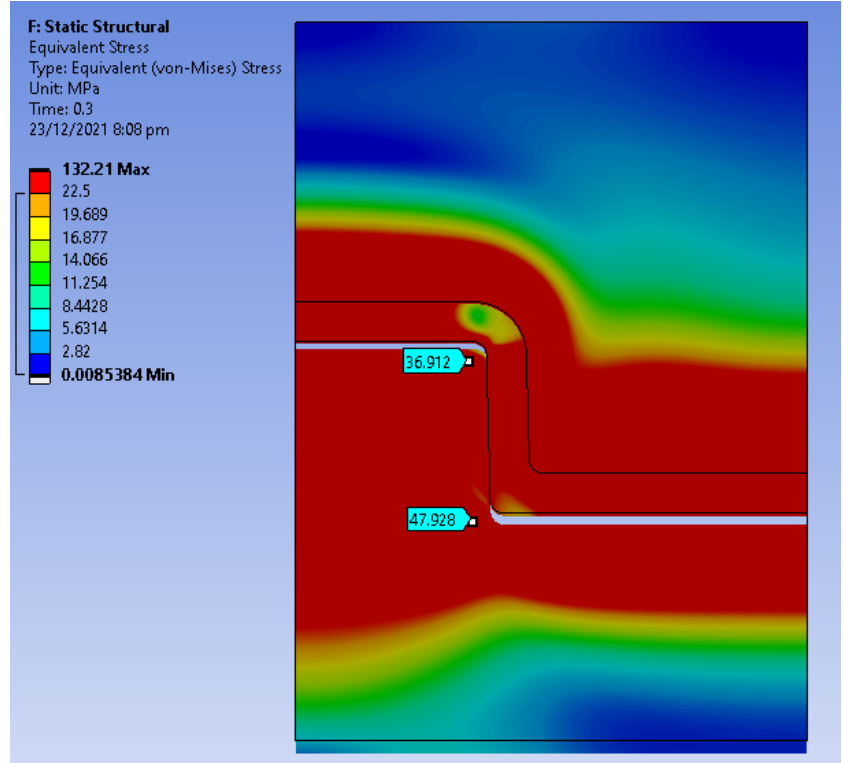
Figure 14. Equivalent stress distribution at 0.1 s.